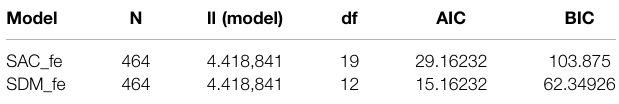
TABLE 6 | Adaptability test of SAC and SDM models. Model